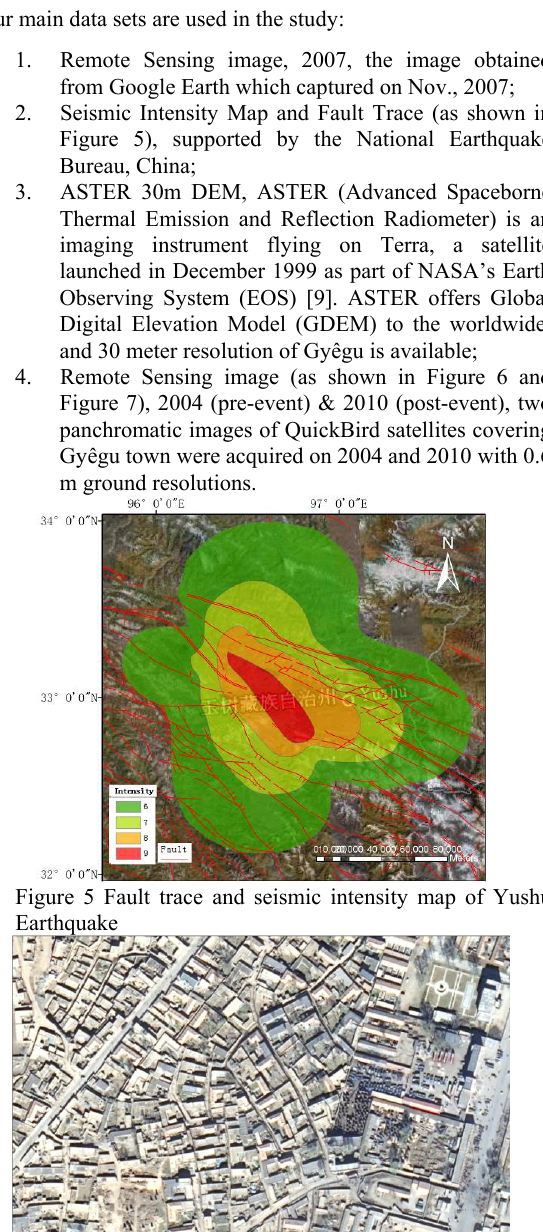
Figure 5: pre-earthquake airborne image of Gyêgu